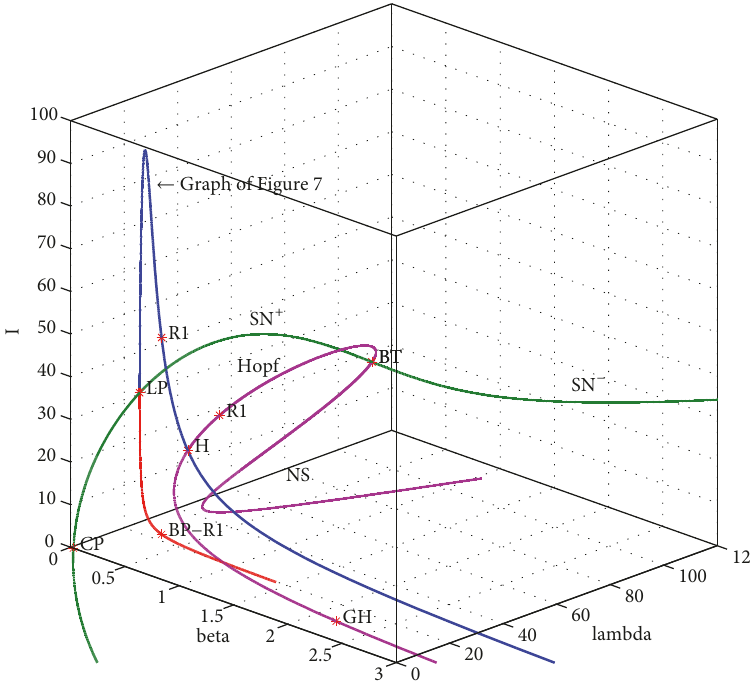
Figure 12: Bifurcation diagram in the (𝛽,𝜆, 𝐼) space near the Bogdanov-Takens point.